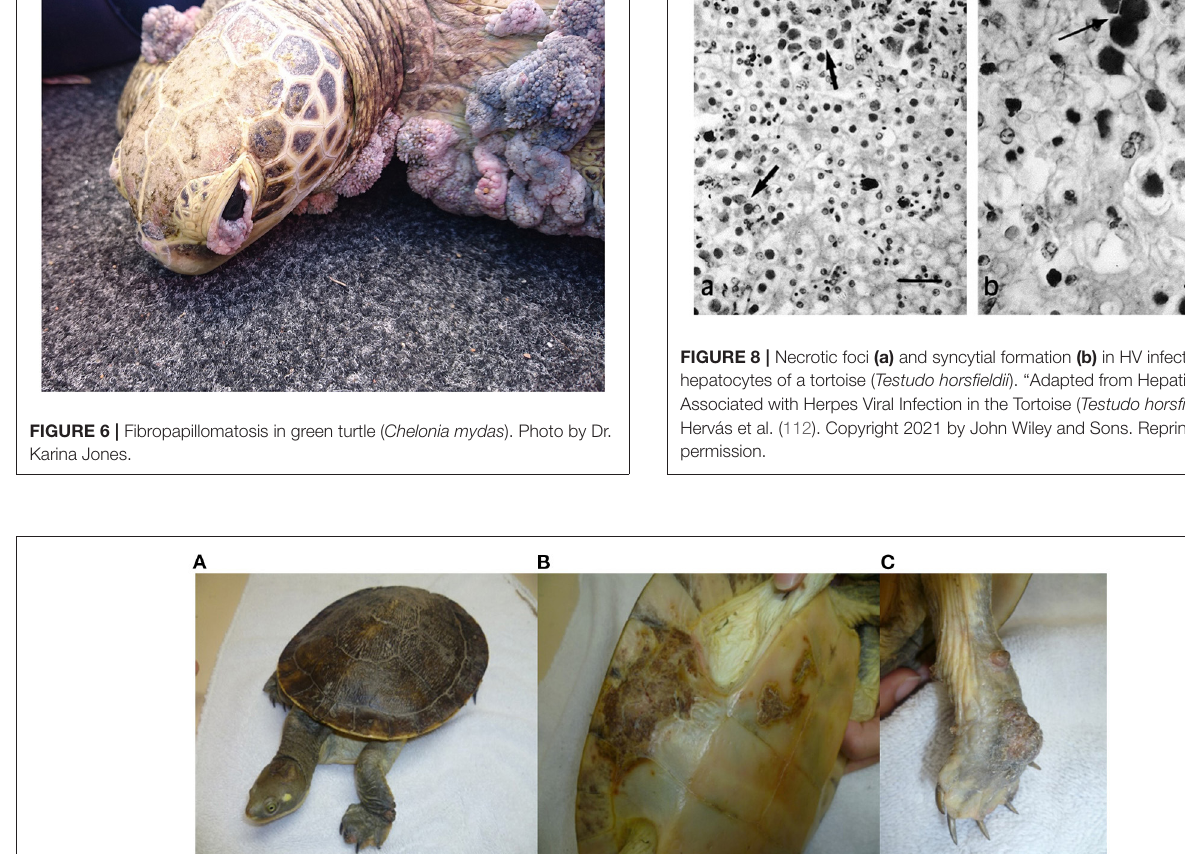
Frontiers in Veterinary Science |